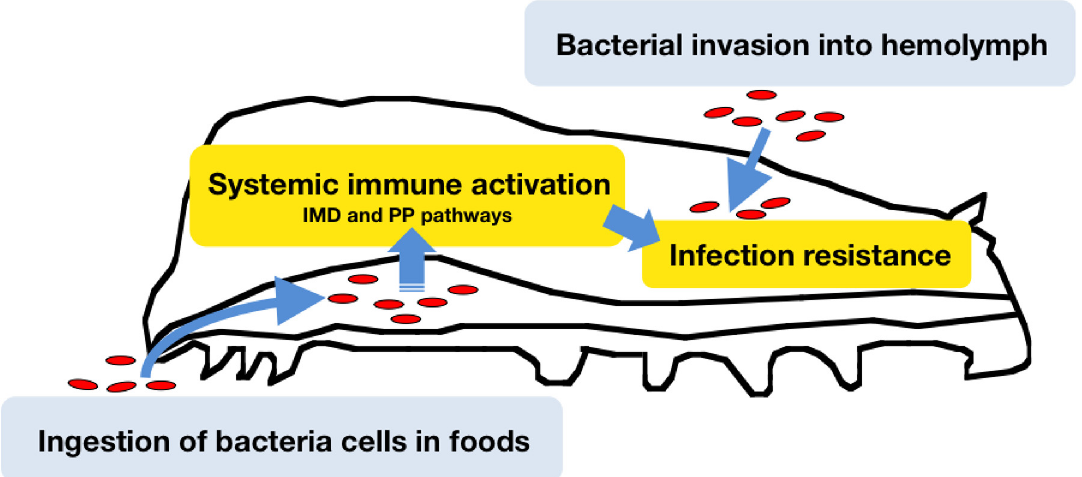
Fig 6. Model of primed immune responses triggered by ingestion of bacteria. Silkworms ingest bacteria with their food. The ingested bacteria activate systemic immune responses in the gut, which leads to tolerance against bacterial invasion into the hemolymph.